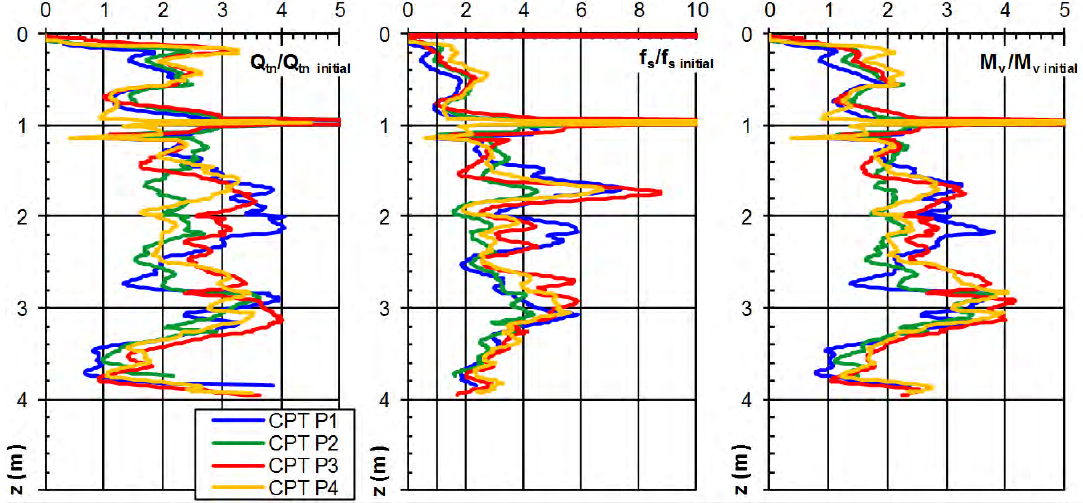
Figure 15. Results of CPT after RIC compared to those before RIC (tests performed by IRGO,